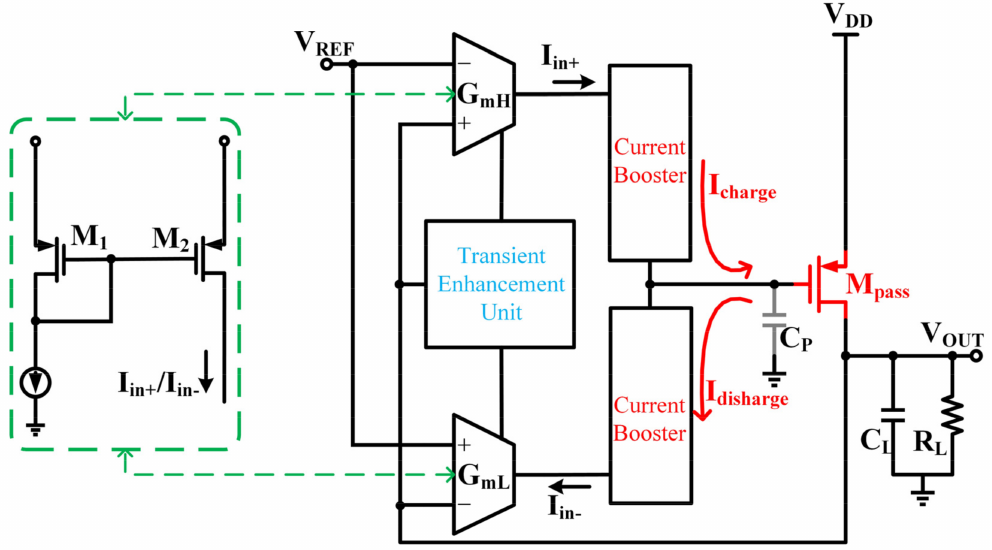
Figure 1. Conceptual schematic of the proposed OCL-LDO